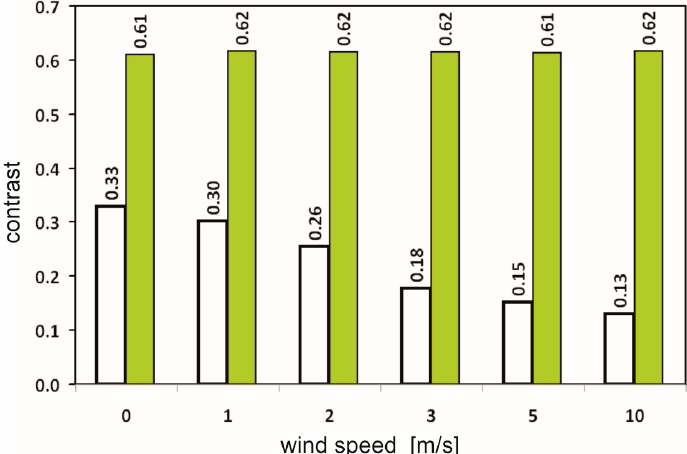
Figure 8. The contrast (according to the Michelson formulae) between clean and polluted sea areas depending on the state of the sea surface, as expressed by wind speed (white bars) (in relation to the Cox–Munk wave slope distribution [17]). Green bars show contrast only if the water column is taken into account (the surface is not included).